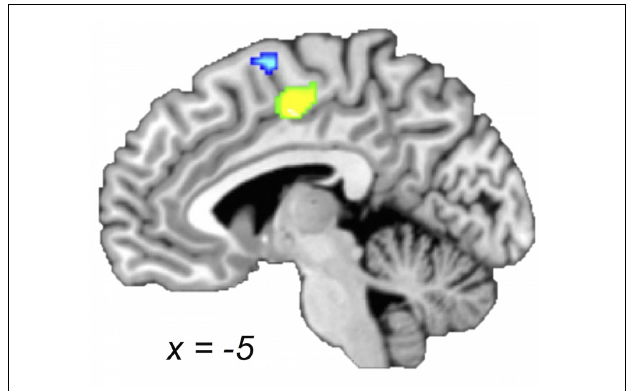
FIGURE 4 | Older and young adults likely recruit different regions of medial premotor cortex. Midsagittal section ( x = − 5) of older > young adult (green) and young > older adult (blue) ALE contrasts (voxel-wise FDR corrected at p < 0.05). Young compared with older adults showed a greater likelihood of activation in a cluster extending into pre-SMA, whereas older compared with young adults showed a greater likelihood of activation in a postero-ventral region of